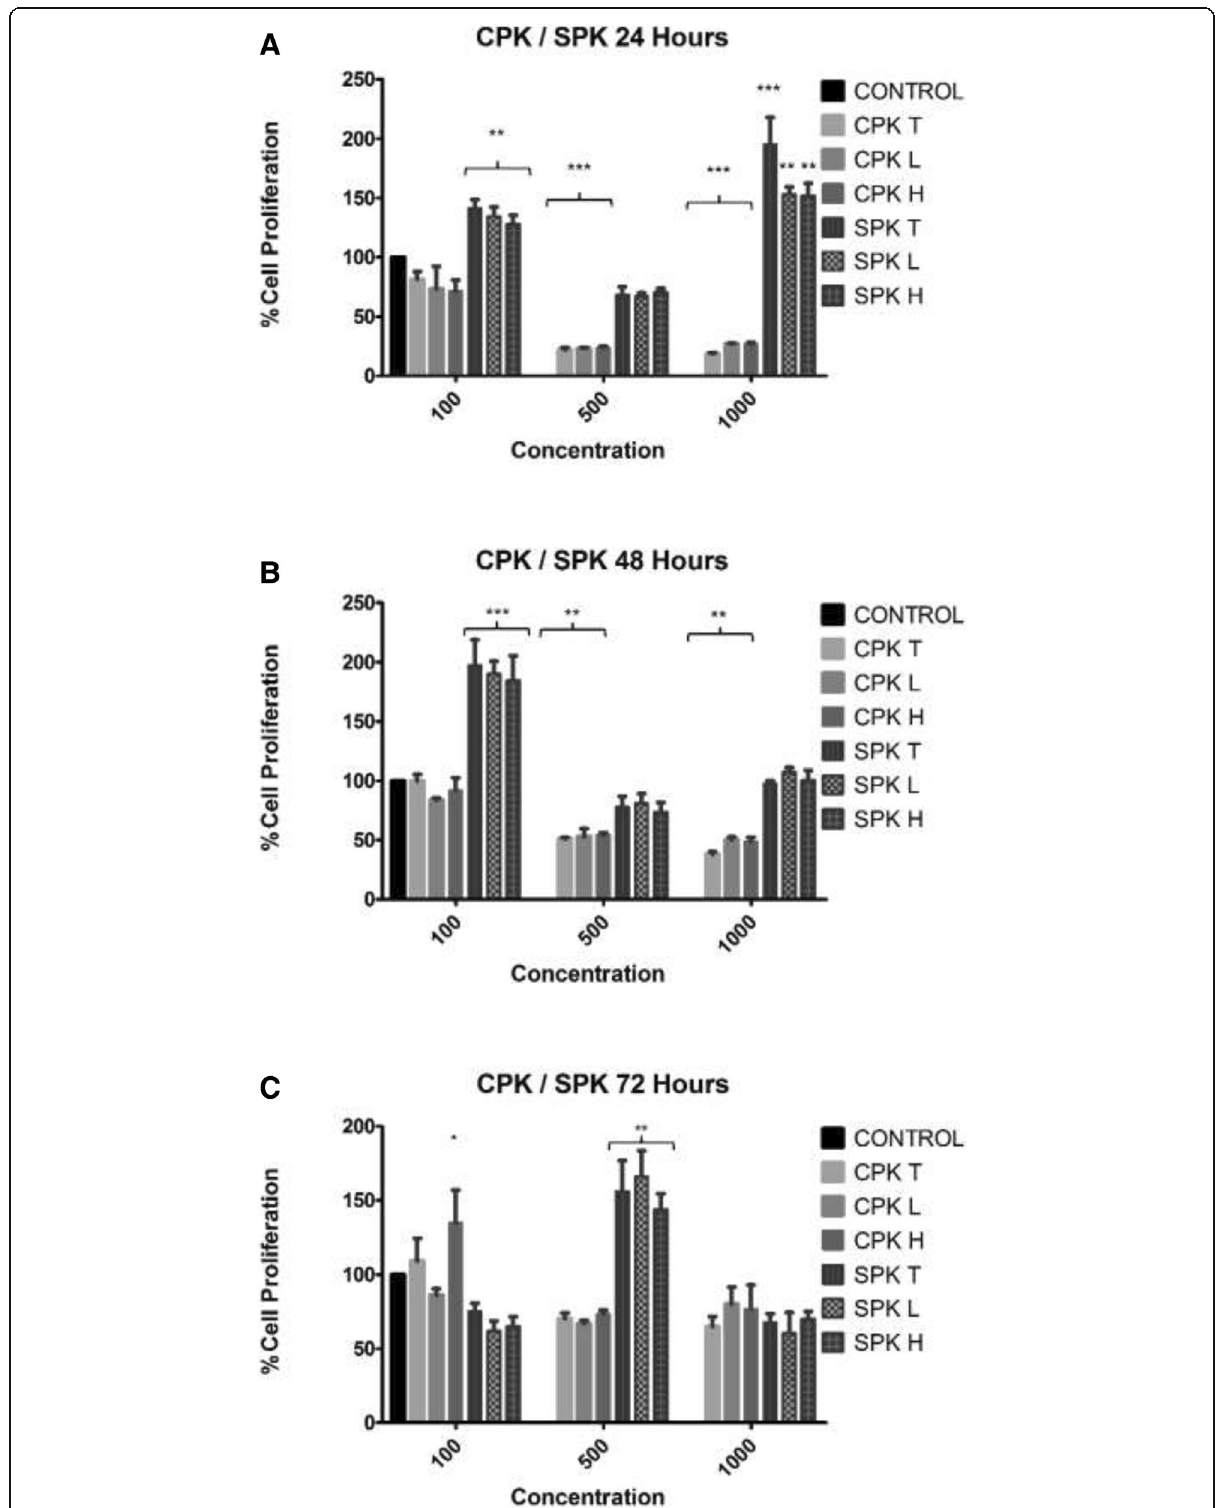
Fig. 2 Percentage of HT-29 cells as determined by crystal violet assay in 96-well plates following 24 ( a ), 48 ( b ), and 72-h ( c ) exposure to CAK and SAK extracts. Data is shown as mean±SEM of three separate experiments. Significant differences between treated and control samples are indicated by * P ≤ 0.05, ** P ≤ 0.01, *** P ≤ 0.001 compared to respective controls (Two-way ANOVA followed by Tukey ’ s multiple comparisons